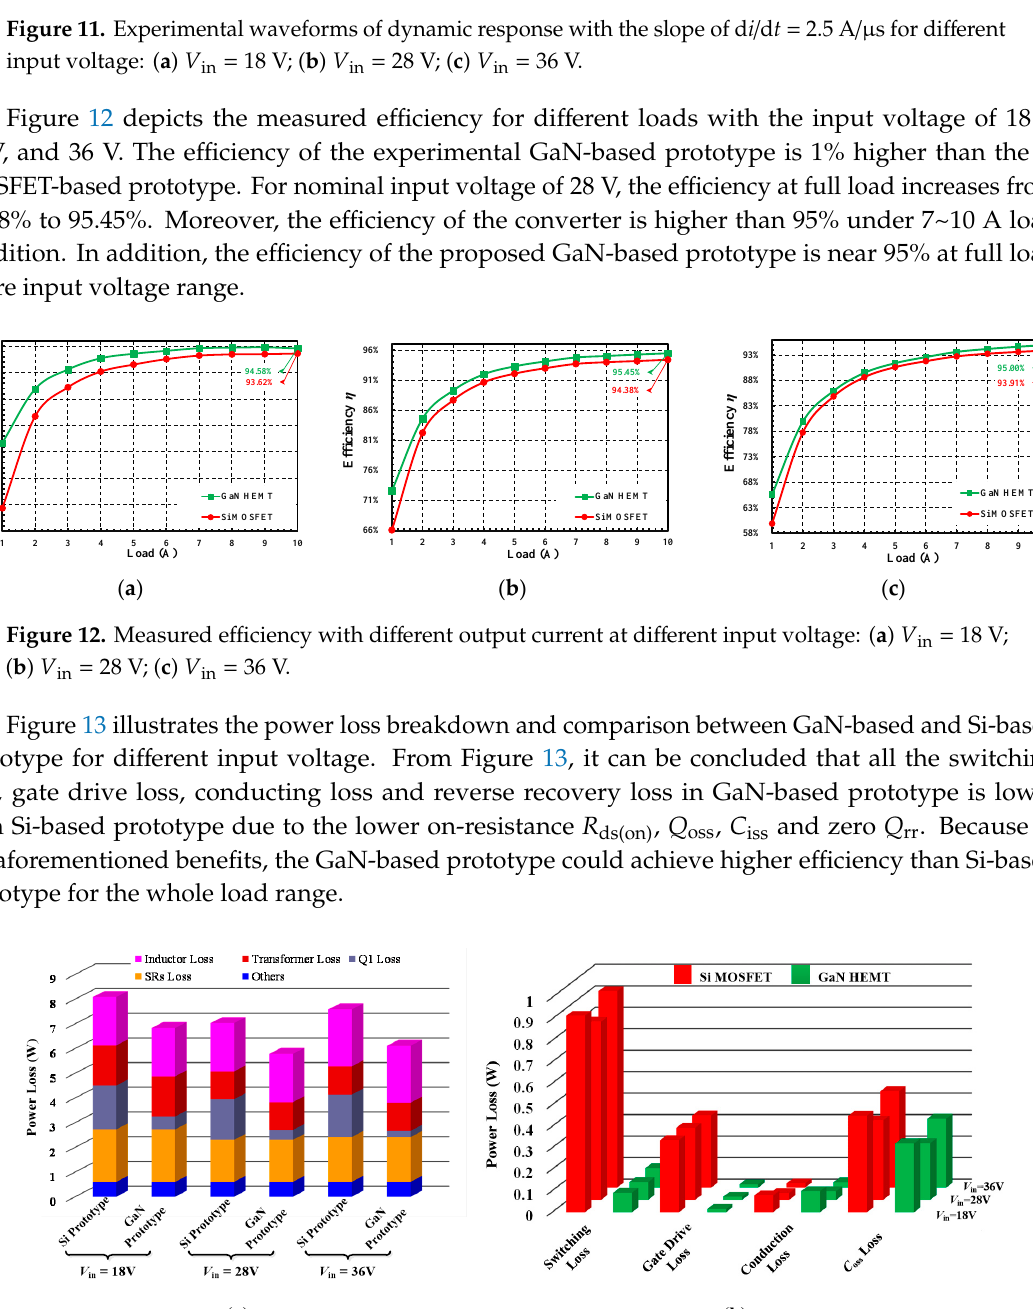
load. Figure 13. Power loss breakdown and comparison between GaN- and Si-based prototype at full ( a ) Power loss breakdown; ( b ) Detailed power loss